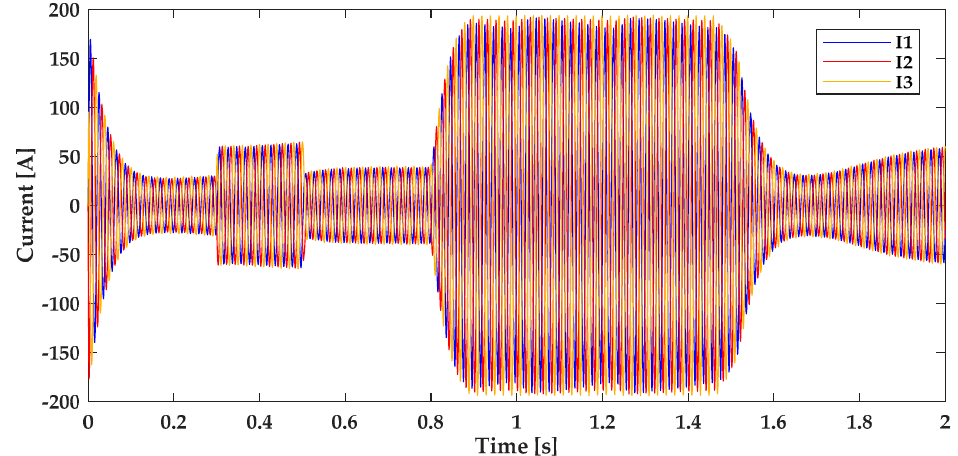
Figure 18. Currents variation at the SST connection: stable operation.